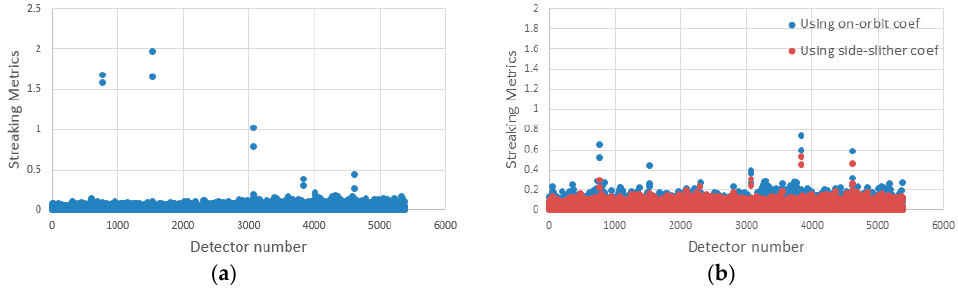
Figure 14. Streaking metrics of city images. ( a ) Streaking metrics of the raw image; ( b ) Streaking metrics of images corrected using on-orbit coefficients and side-slither coefficients, respectively.